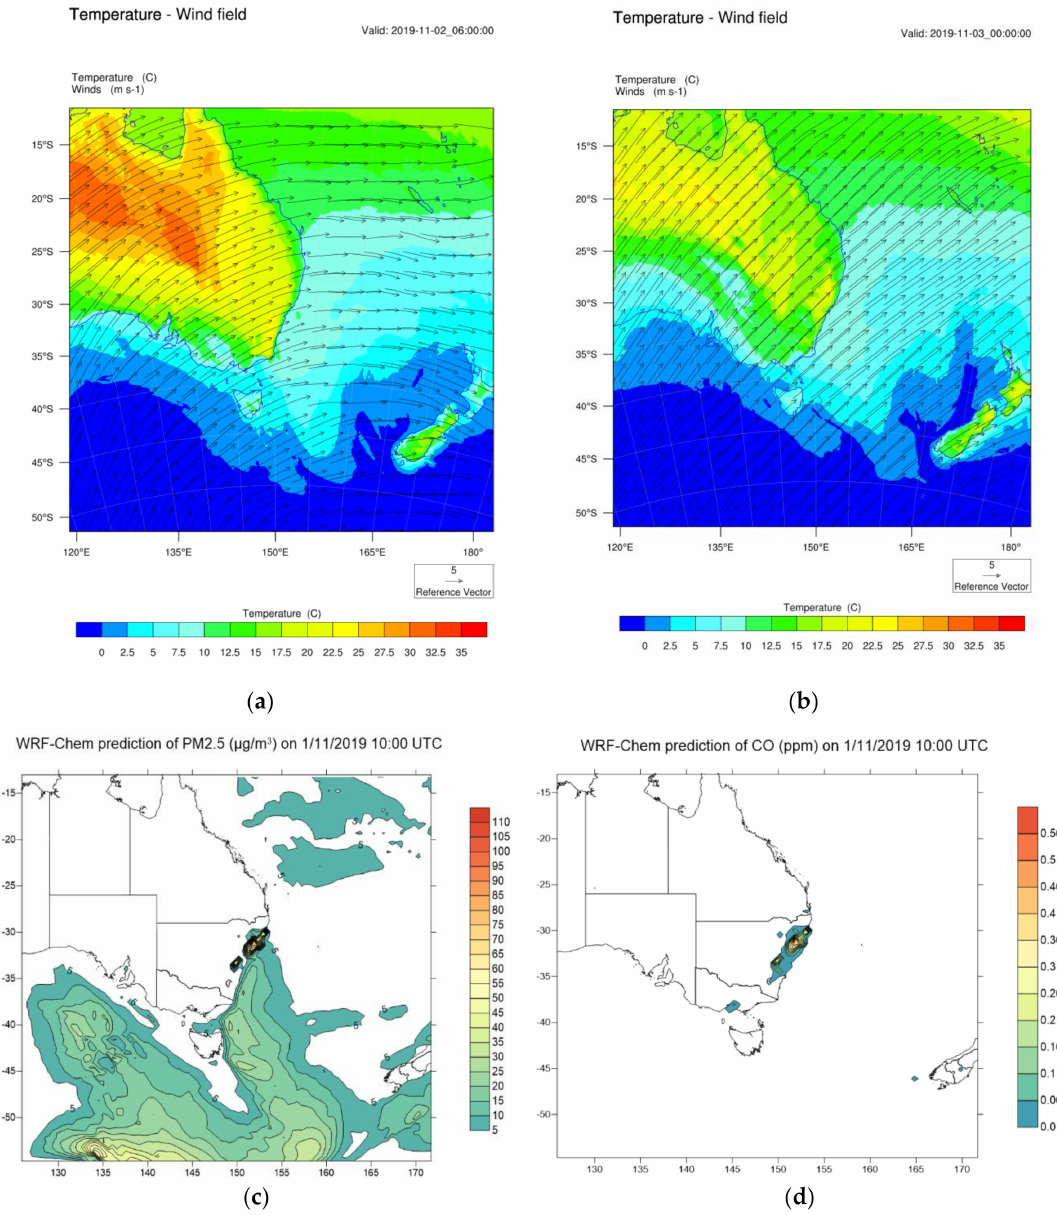
Figure 5. Predicted surface wind and temperature on ( a ) 2 November 2019, 06:00 UTC, and ( b ) 3 November 2019, 00:00 UTC. ( c ) Predicted PM 2.5 on 1 November 2019, 10:00 UTC, with marine aerosols dominating over the coast and offshore. ( d ) CO concentration on the ground with a high concentration to the southwest of the fires on 1 November 2019 at 10:00